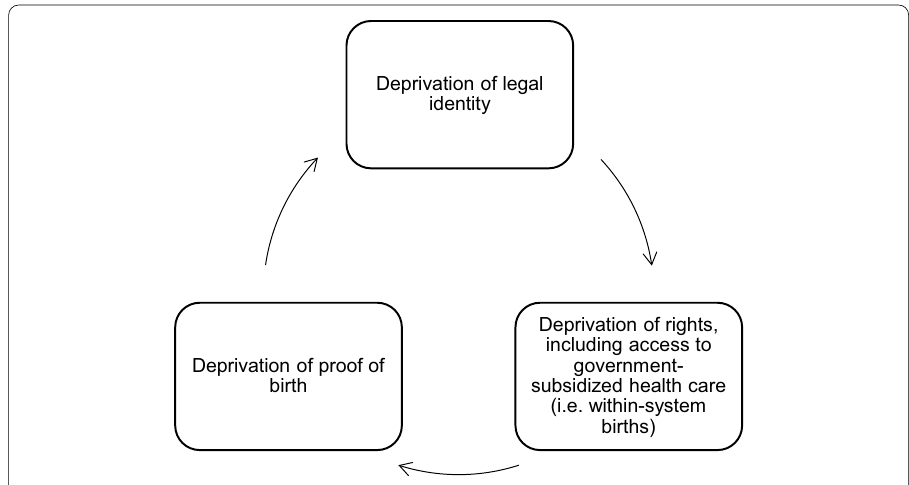
Fig. 2 The intergenerational cycle of exclusion from civil registration and healthcare